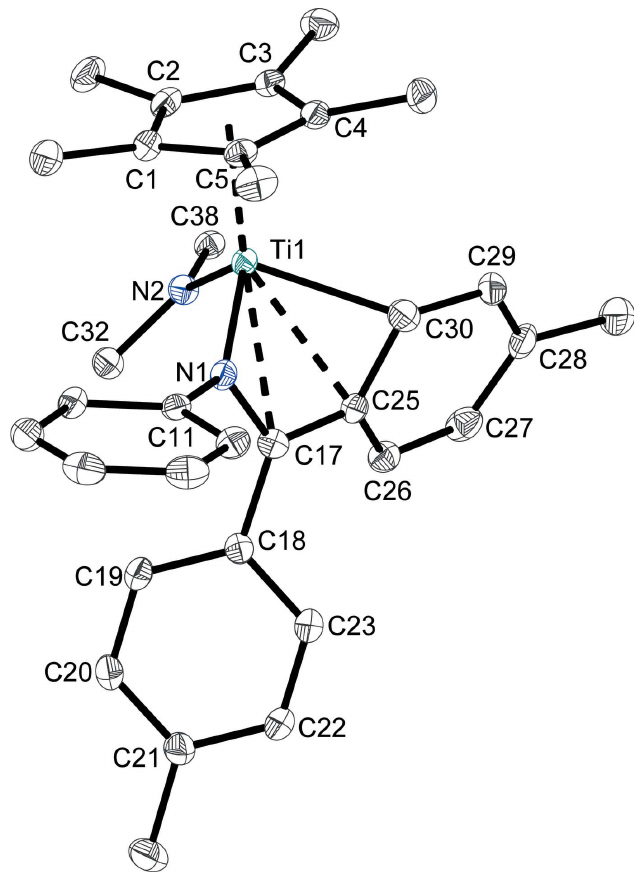
Figure 1 The molecular structure of 1 , with displacement ellipsoids at the 50% probability level. H atoms and phenyl groups of the diphenyl amido moiety have been omitted for